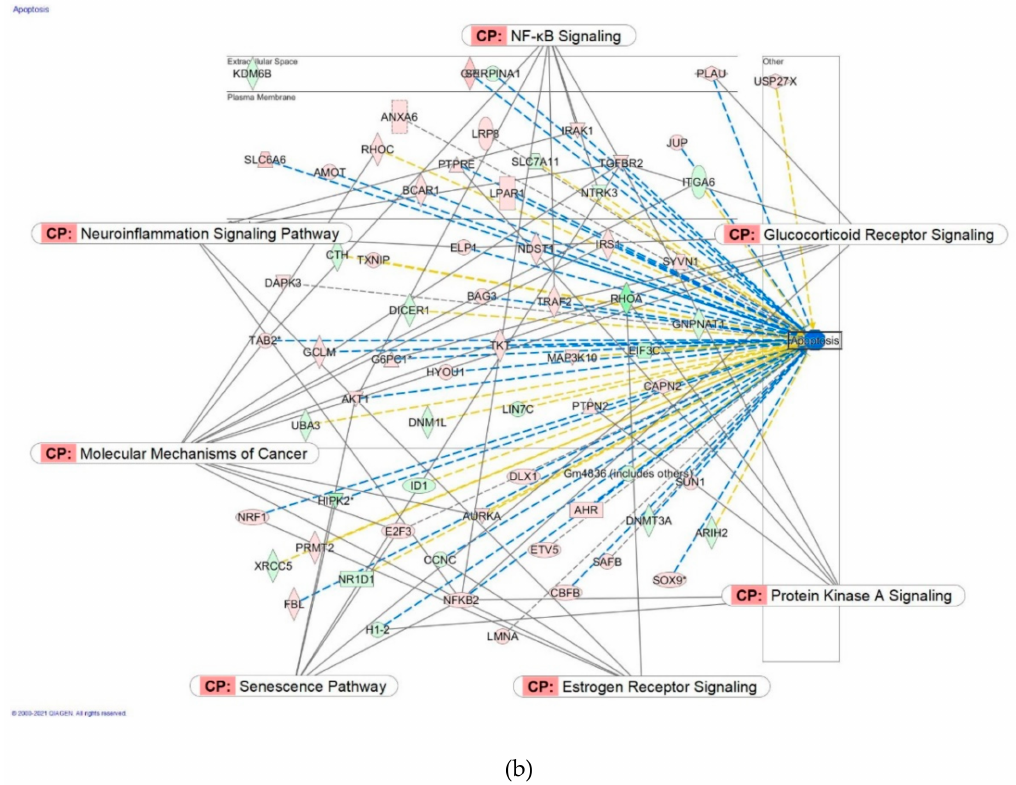
Figure 18. Predicted effects of Rg5 on apoptosis: ( a ) activation (brown) at a concentration of 100 µ M; ( b )—predicted inhibition (blue) at a concentration of 1 pM.